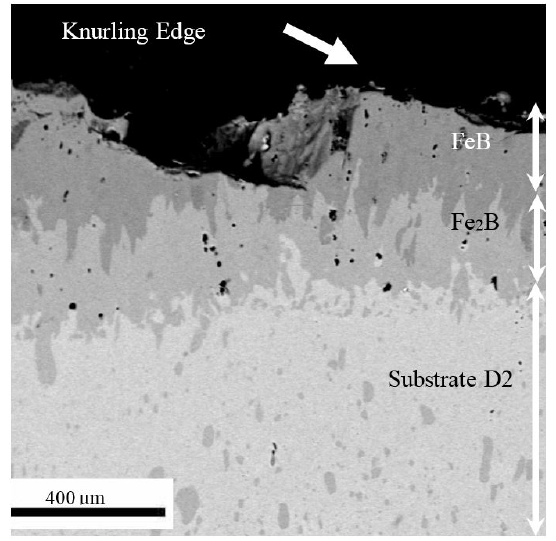
Figure 9. Cross ‐ section SEM image of the knurled and borided double ‐ layered Fe 2 B and FeB. Figure 9. Cross-section SEM image of the knurled and borided double-layered Fe 2 B and